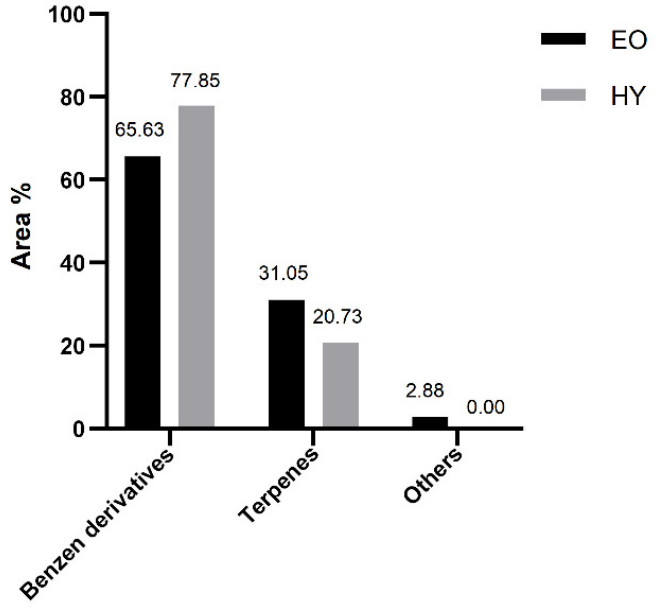
Figure 1. Volatile organic compounds of air-dried P. ramosissima isolated by hydrodistillation, ana- lyzed by gas chromatography-mass spectrometry and sorted by structural groups. EO—essential oil; HY—hydrosol.